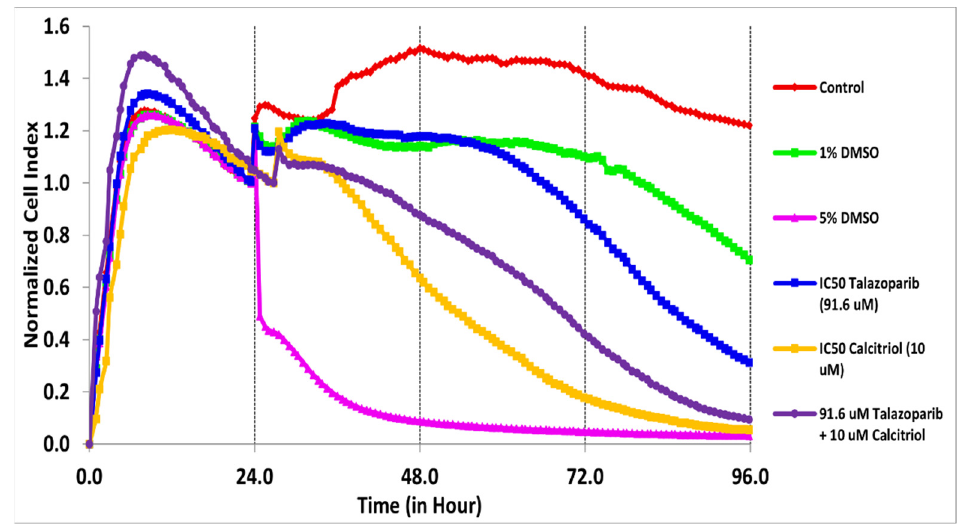
Figure 1. Antiproliferative effect of talazoparib and calcitriol on BT − 20. Cells were seeded overnight (1 × 10 4 cells/well on E − plates) to reach the log phase, then incubated with IC 50 of 91.6 µM talazoparib and 10 µM calcitriol for 96 h. Data are represented as the mean ± SD ( n = 3). The drugs were added after 24 h. The green color line is vehicle control (1% DMSO) and the pink color line is the positive control (5% DMSO). Raw data can be found in Supplementary File S1.